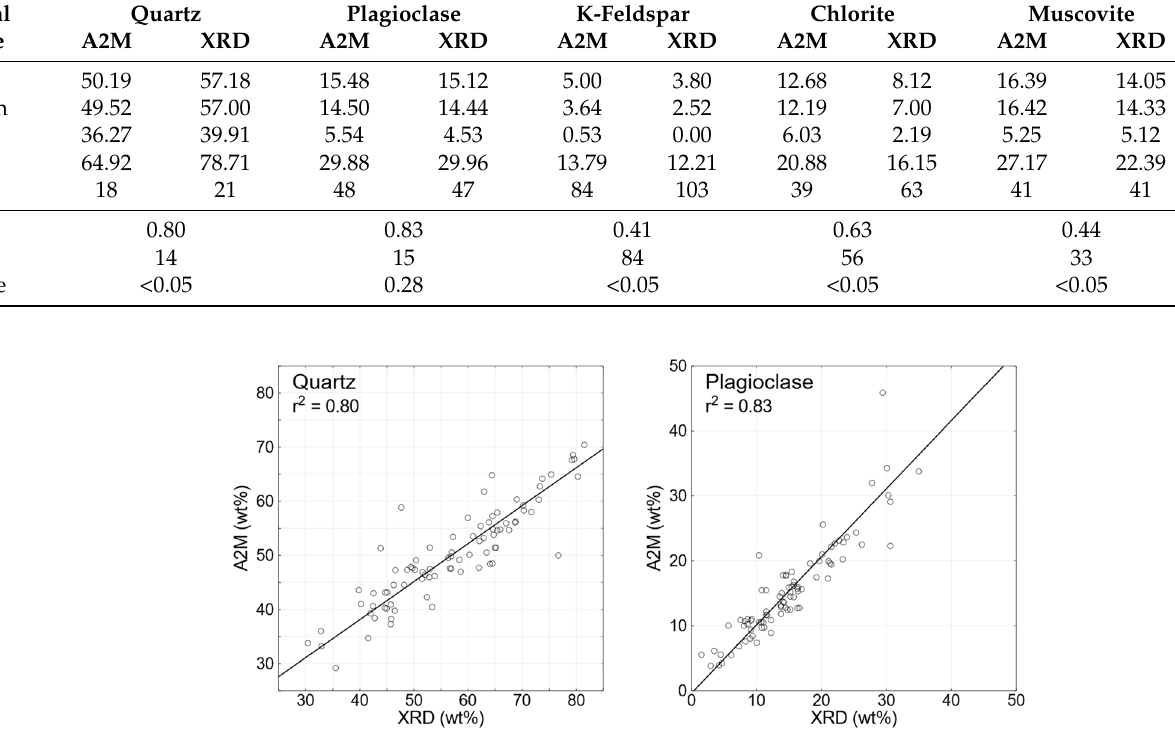
Figure 4. Sca tt er plots with total least-square regression line fi t of estimated XRD versus predicted A2M quantitative mineralogy (for quar tz , plagioclase, k-feldspar, chlorite, and muscovite) in soil (depth-weighted to a maximum of 50 cm) at 85 study sites across New Brunswick, Nova Scotia, and Prince Edward Island. 3.3. Canada-Wide Predicted Soil Mineralogy Average predicted major mineralogy (w%) for all soil pro fi les ( n = 1170; depth- weighted to 50 cm) ranked in the order of quar tz > plagioclase > chlorite ≈ muscovite> potassium feldspar (Table 4), which is the typical order of abundance for these minerals in Canadian soils [41]. However, the ranking order varied slightly by province (Table 4), e.g., plagioclase was the dominant mineral across sites in British Columbia, and muscovite was the second dominant mineral in New Brunswick, Prince Edward Island, and Nova Scotia (13.67–18.17 wt%; Table 4, Supplementary Material Figure S7), which may be due to elevated weathering and the breakdown of muscovite into illite (clay minerals). Study sites in all provinces, with the exception of Prince Edward Island, required additional minerals in their prescribed mineral list (Table 1) for A2M to generate a solution. These minerals included hornblende (~30% of the sites), calcite (~21% of the sites), and kaolinite (~7% of the sites). The mineral data were not normally distributed (Shapiro–Wilk, p < 0.05);